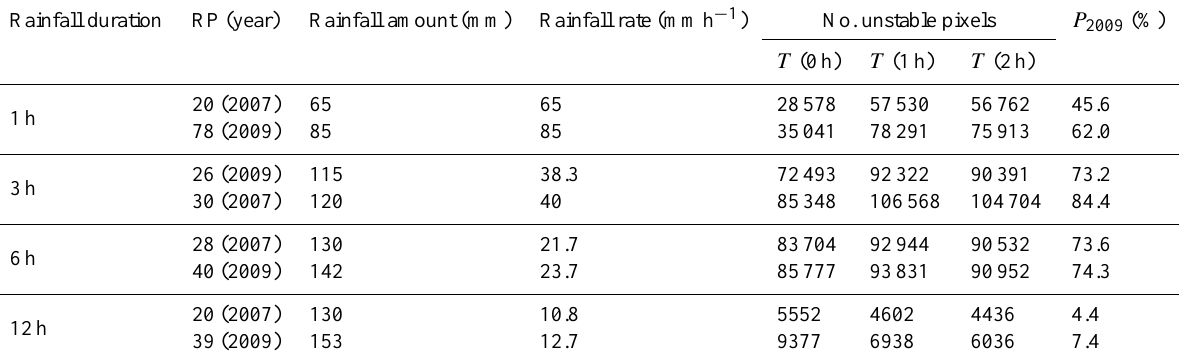
Table 9. Number of unstable pixels predicted by TRIGRS by using the rainfall amounts recorded during the 25 October 2007 and 1 October 2009 event. Data have been computed at the end of the simulated rainfall scenario T (0) and in the next 2h T (1h) and T (2h). P 2009 represents the percentage of the maximum number of predicted unstable pixels compared to those obtained in the back analysis of the 1 October 2009